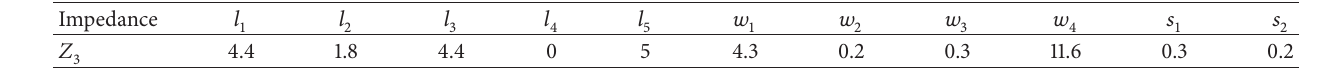
Figure 7: Ameliorated artificial transmission line of characteristic impedances 23.5 Ω and 32.8 Ω . Table 1: Dimensions of artificial transmission lines of 𝑍 3 (unit: mm).